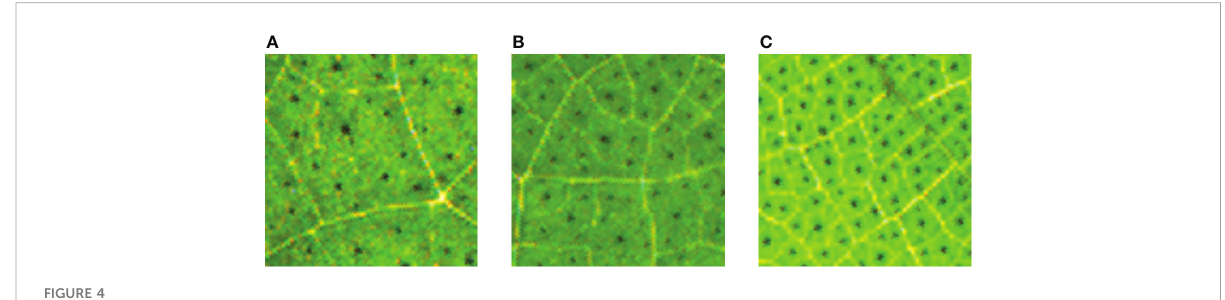
FIGURE 4 The sub-images of three datasets with different densities. (A) DS1; (B) DS2; (C)